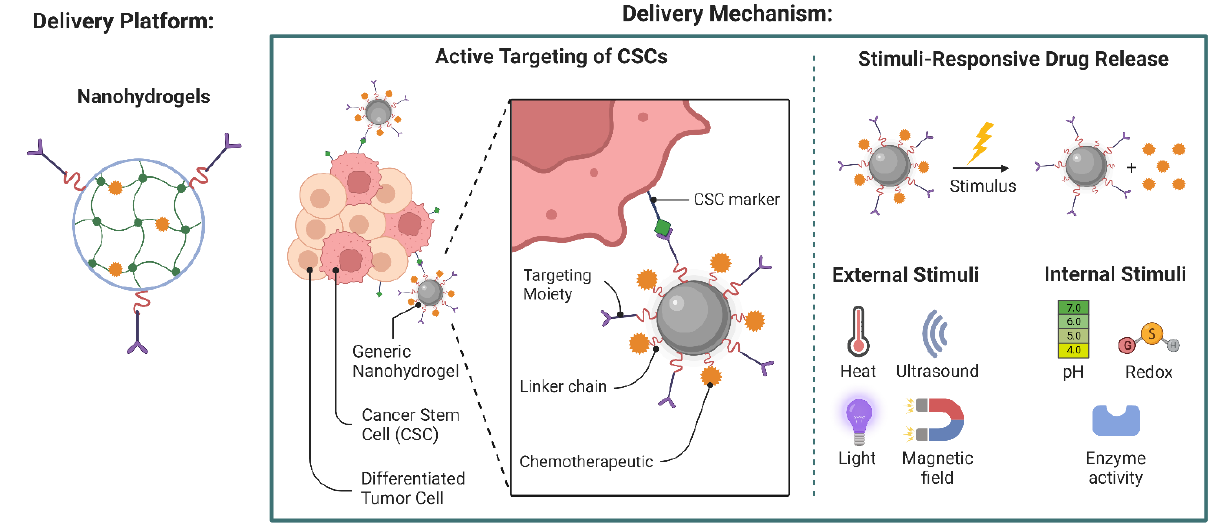
Figure 3. Nanoparticles directly deliver drugs to cancer stem cells (CSCs). These cells, known as CSCs, can self-renew and differentiate into a wide variety of tumor cell types.